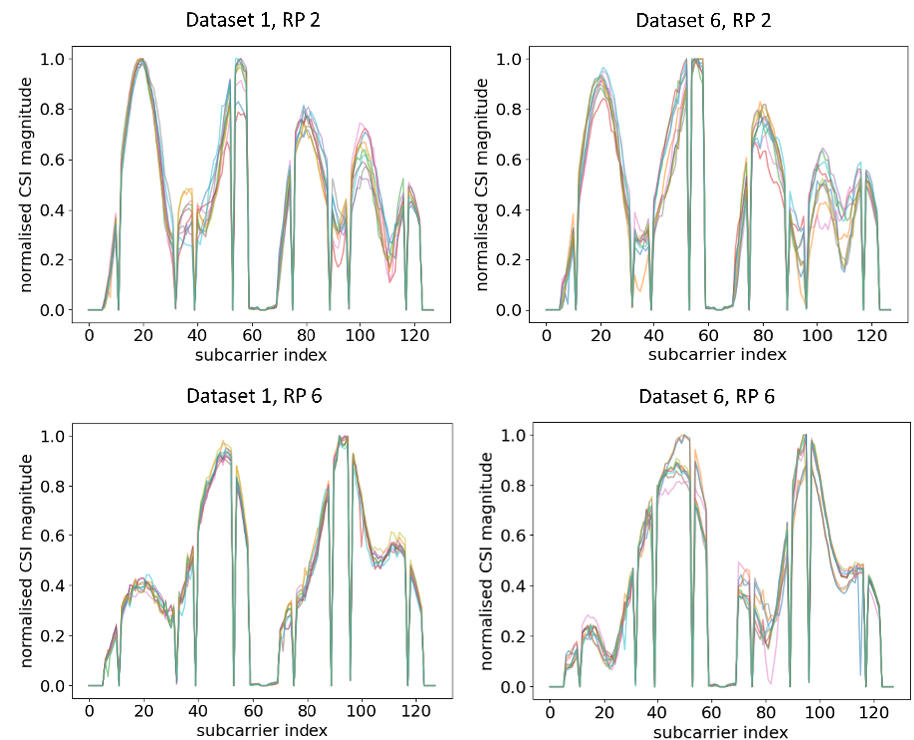
Figure 5. Plots of CSI amplitude during two different time periods at different RPs using AP 1, showing a similar trend in different time periods.